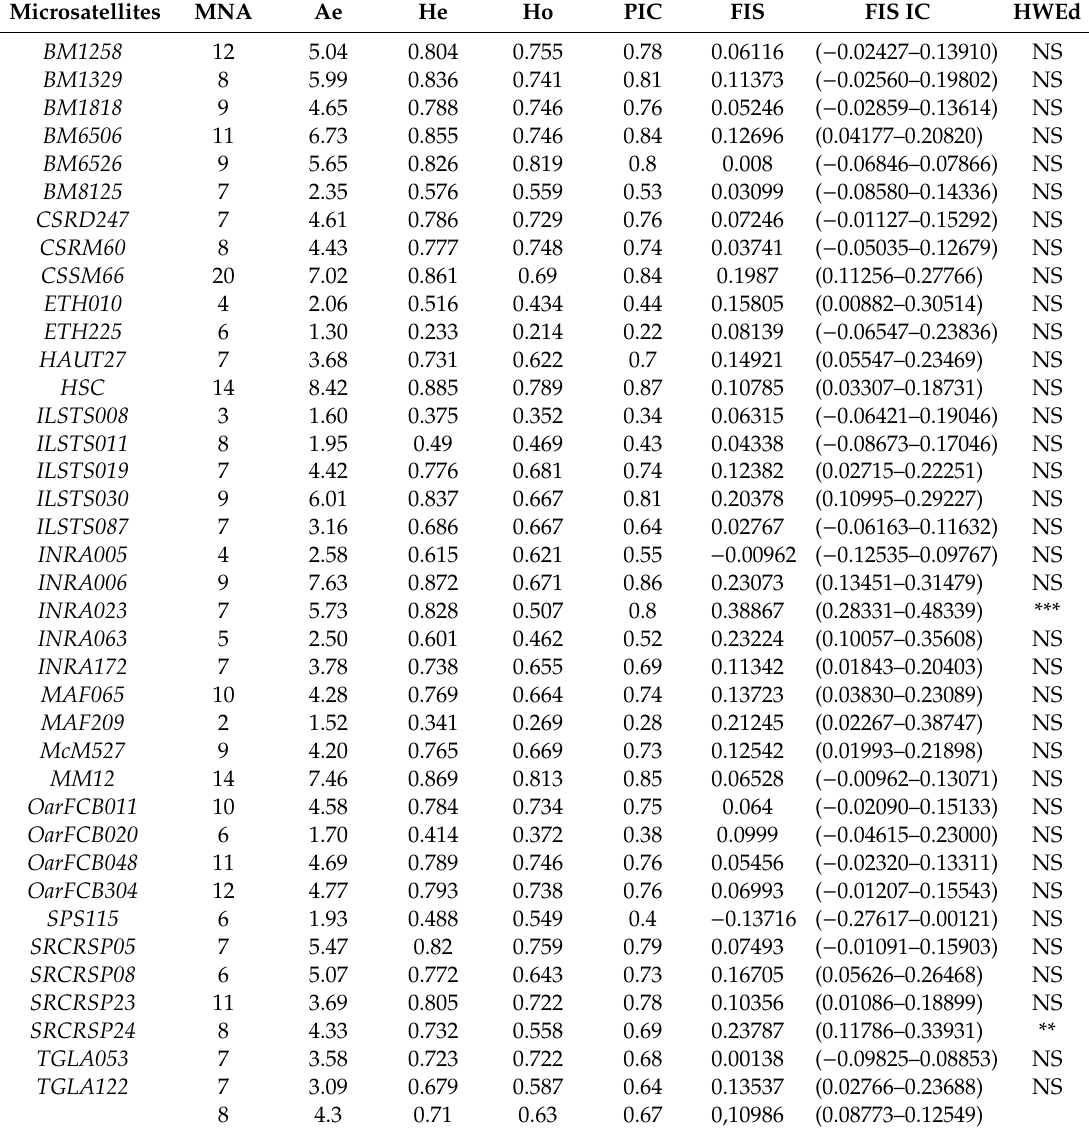
Table 2. Genetic results of the “Chusca Lojana” goat: microsatellites, mean number of alleles (MNA), e ff ective number of alleles (Ae), expected heterozygosity (He), observed heterozygosity (Ho), polymorphic information content (PIC), F IS values and confidence interval, and Hardy–Weinberg equilibrium (HWE)